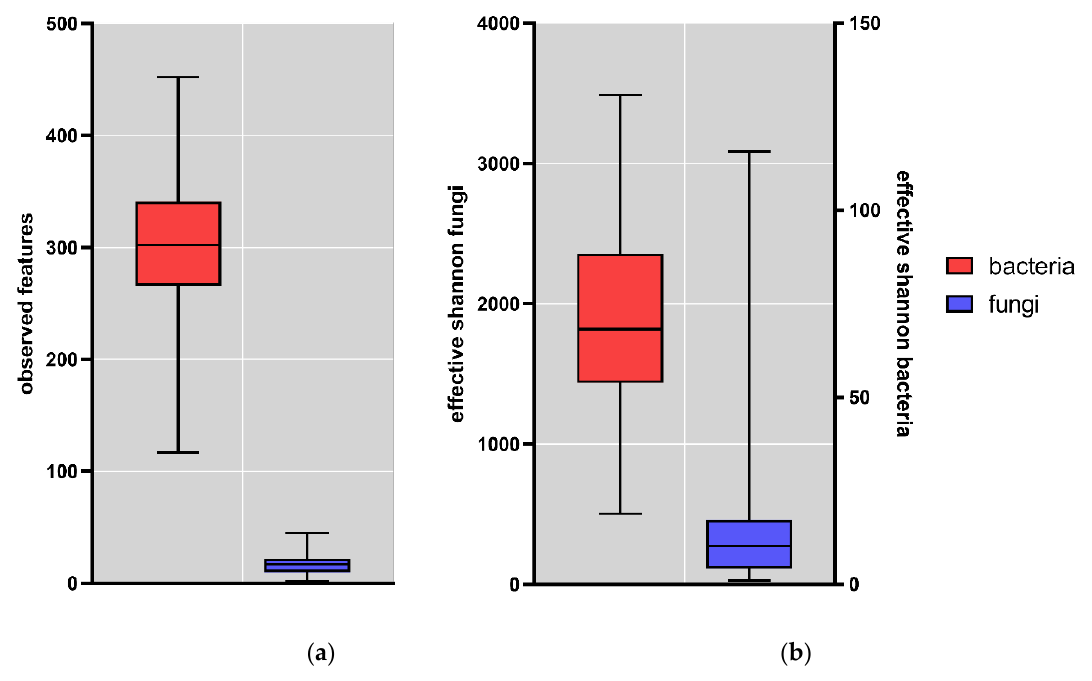
Figure 1. Box plots of alpha-diversity indexes of the fecal samples (N = 163); ( a ) Observed features fungi (blue) and bacteria (red); ( b ) Effective Shannon fungi (blue) and bacteria (red). Whisker: min to max; horizontal line = median; box = 25th to 75th percentile.